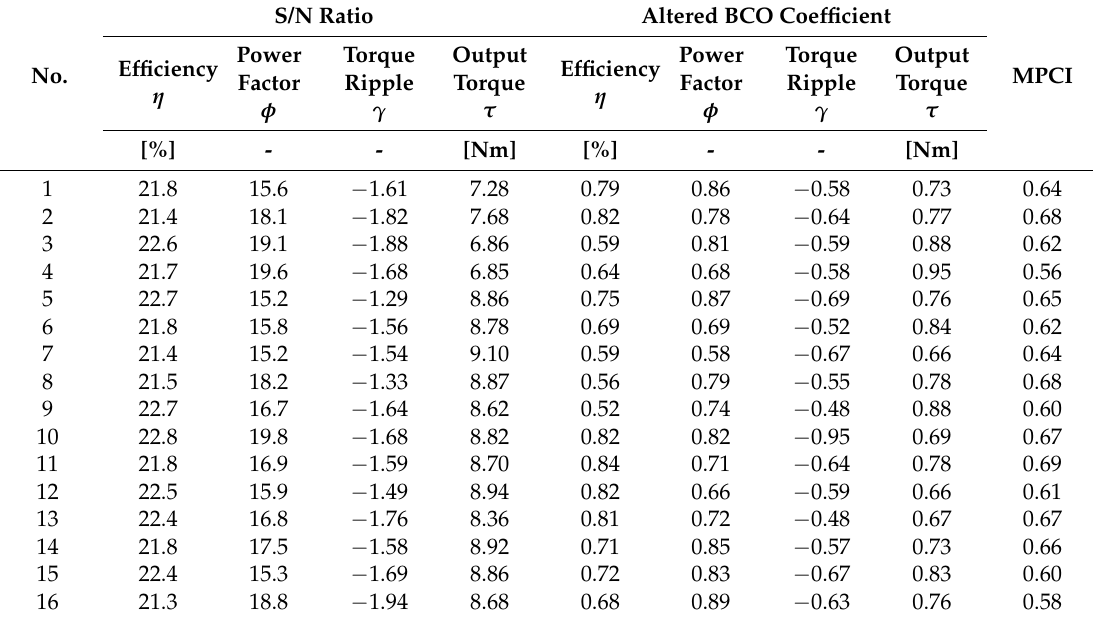
Table 3. Transformations matrix of S/N ratios, altered BCO coefficient and MPCI.